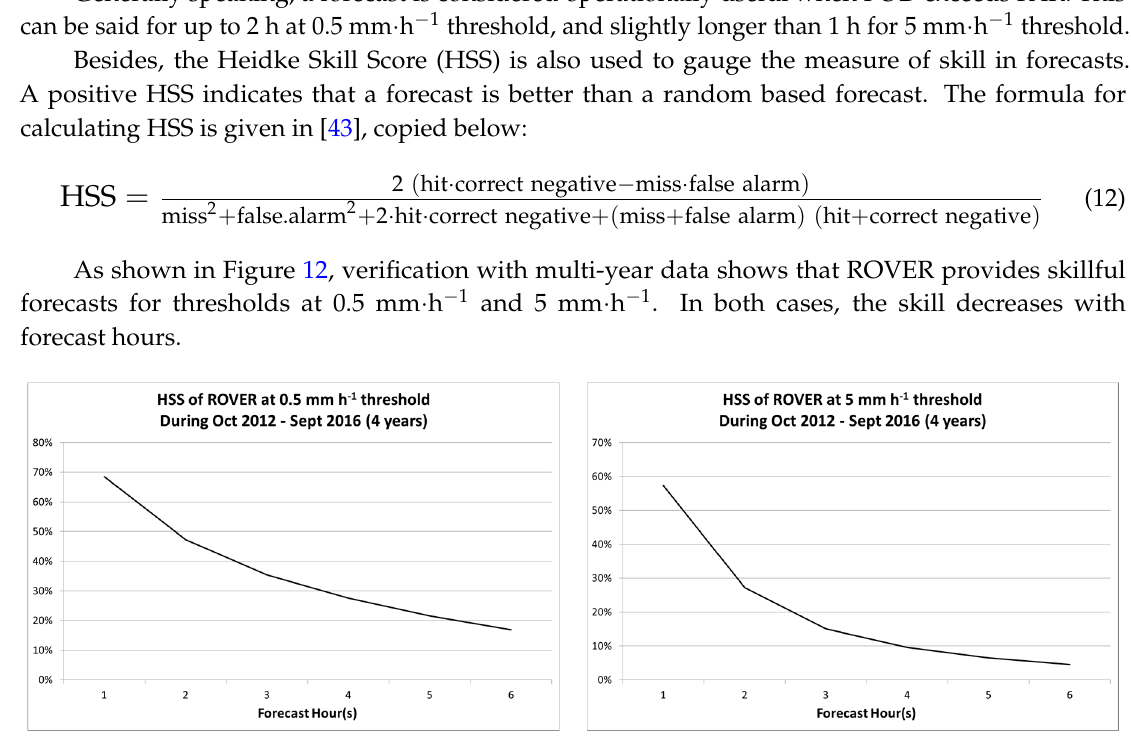
Figure 11. POD and FAR of ROVER at: ( a ) 0.5 mm·h − 1 ; and ( b ) 5 mm·h − 1 thresholds based on four years of data.